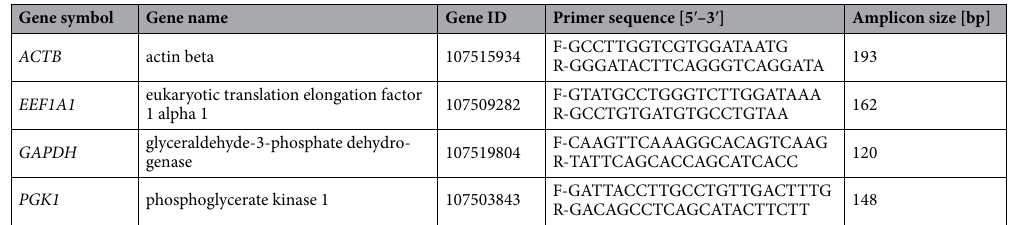
Table 4. Summary of selected reference gene